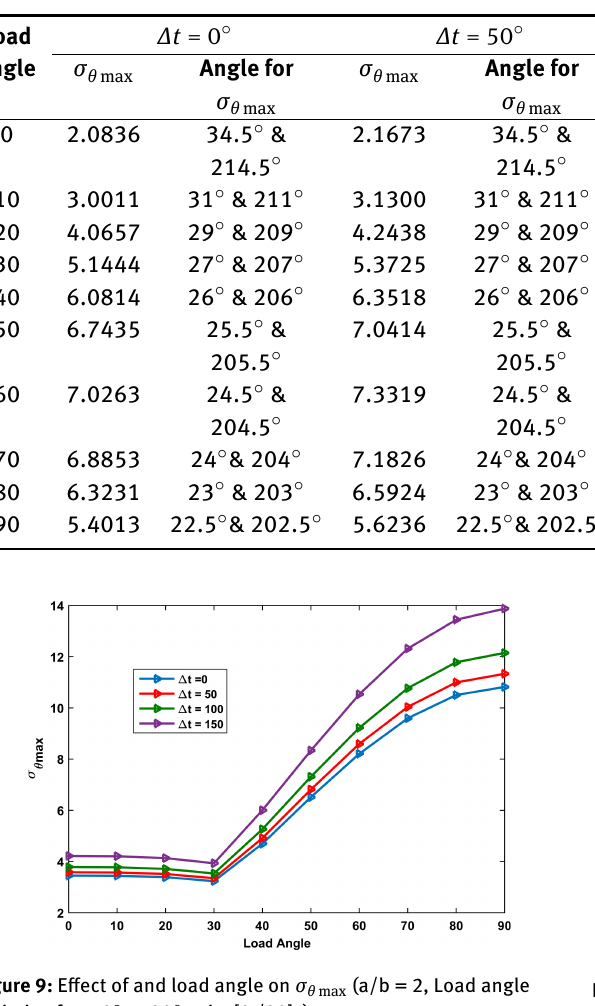
angle plate laminate subjected to tensile loading along x axis ( σ ∞ x = 1). From the Table 5, it is clear that volume frac- tion of a fibre has a least effect on stress concentration as compared with the change in temperature. If fibre fraction is increased from 0.4 to 0.8 at ∆t = 0 ∘ , there is 4.5 % change in the σ but for Vf =0.1 & ∆t changed from 0 ∘ to 150 ∘ θ max there is 24% change in the σ θ max